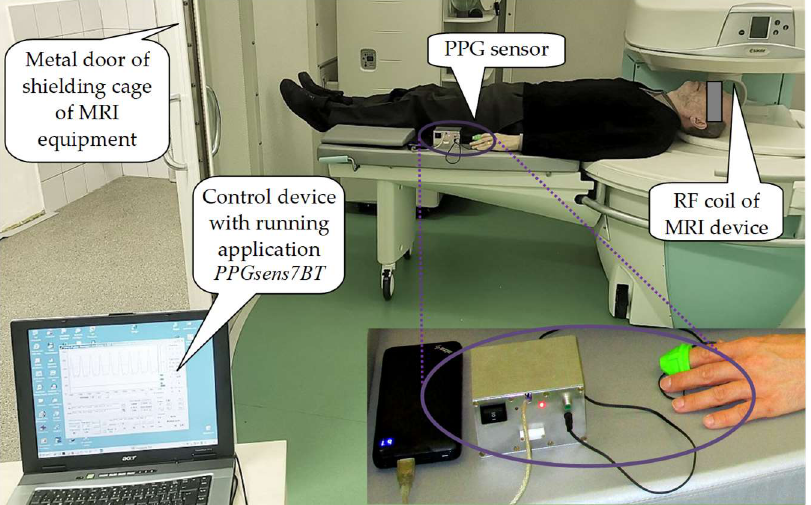
Figure 11. Measurement of a person lying in the MRI device Opera using the PPG-EP sensor with BT data transmission to a control device located outside the shielding metal cage.